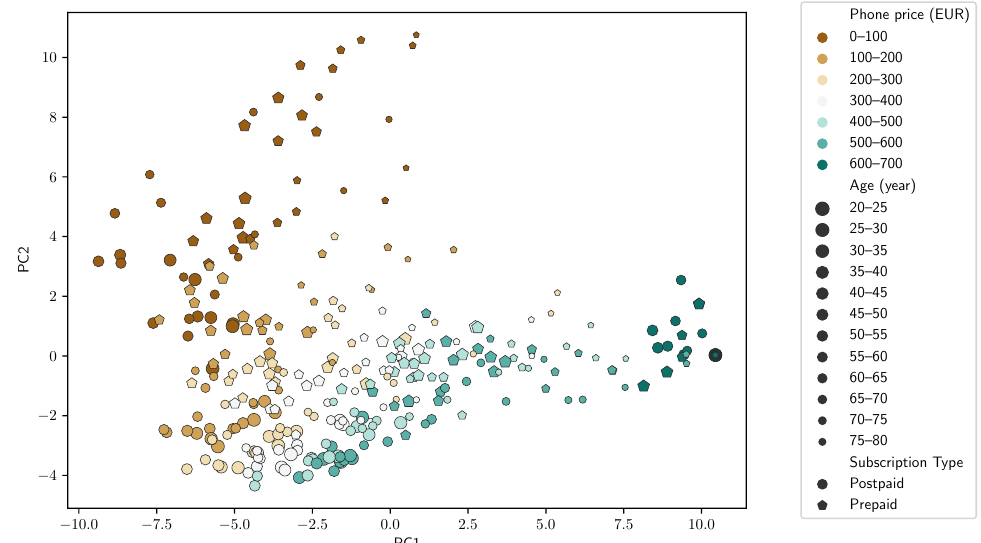
Figure 7. Scatter plot of the 2-component PCA. Marker sizes indicate subscriber age category, where the color represents the phone price category and the subscription type (prepaid/postpaid) is distinguished by the marker